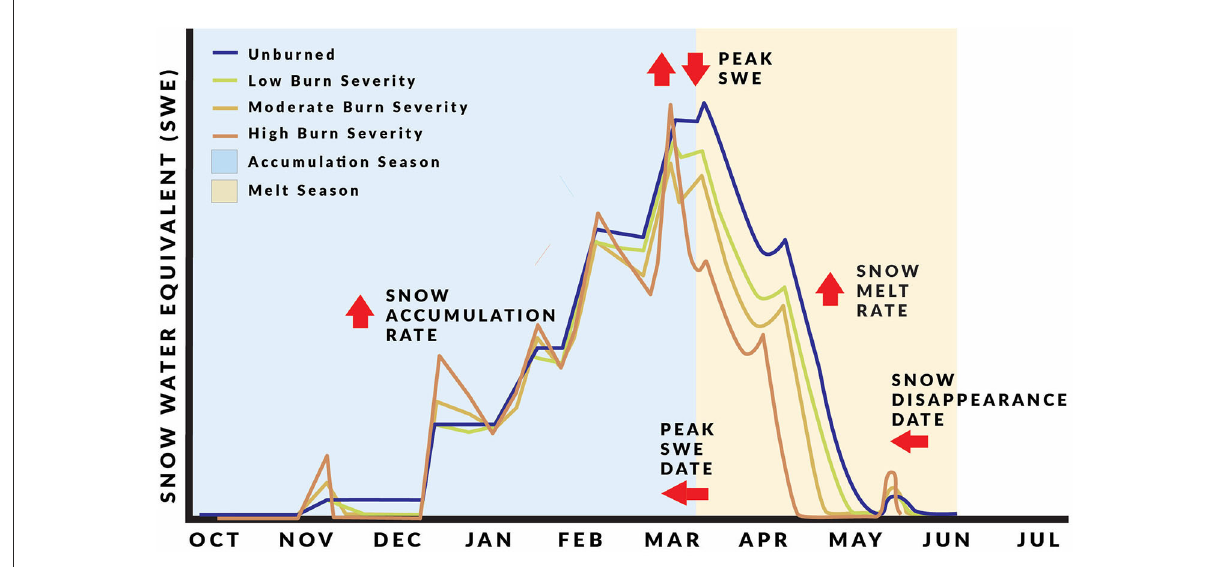
FIGURE2 Synthesis of five snow metrics after a wildfire delineated by burn severity including peak snow water equivalent (peak SWE), peak SWE date, snow disappearance date (SDD), snow accumulation rate, and snowmelt rate. Red arrows denote changes after a wildfire.